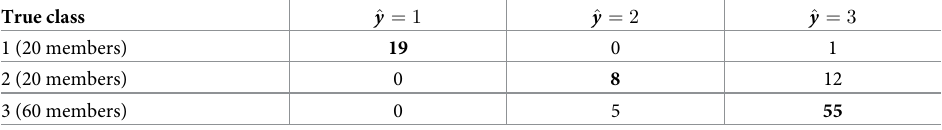
Table 5. Confusion matrix. Confusion matrix (error matrix): the entry in row k and column l is the number of test datapoints which belong to class k and for which our CASIMAC predicts the class label l . Correct classifications (on the diagonal) are highlighted in bold. There are no misclassifications between members of the classes 1 and 2, as can be expected from Fig